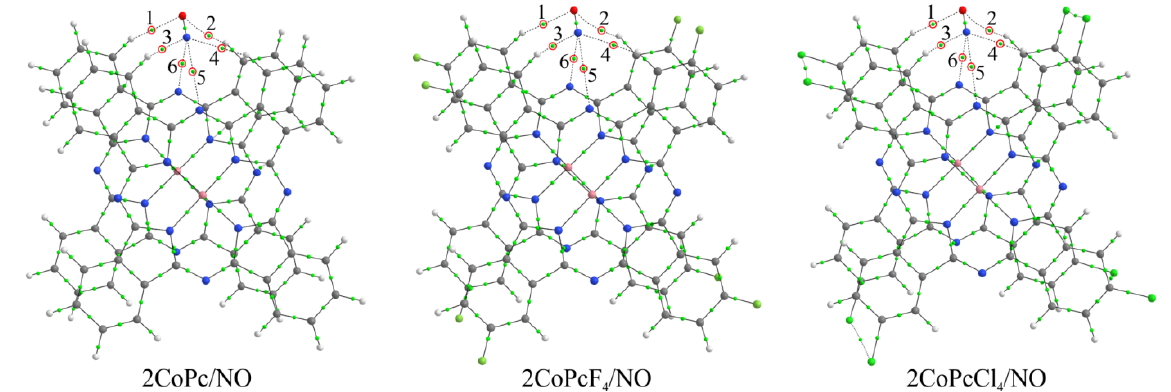
Figure 15. Structure of 2CoPcR 4 /NO aggregates, where R = H, F, and Cl, and bond critical points in them. Red circles and numbers 1–6 indicate BCPs characterizing the NO molecule interaction with phthalocyanine